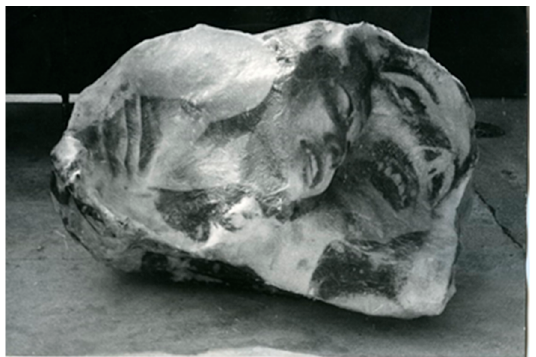
Figure 4. Alina Szapocznikow, Grand Tumor I , 1969, polyester, photographs, 73 × 93 × 97 cm. © ADAGP, Paris. Courtesy of The Estate of Alina Szapocznikow/Piotr Stanislawski/Galerie Loeven- bruck, Paris/Hauser & Wirth.